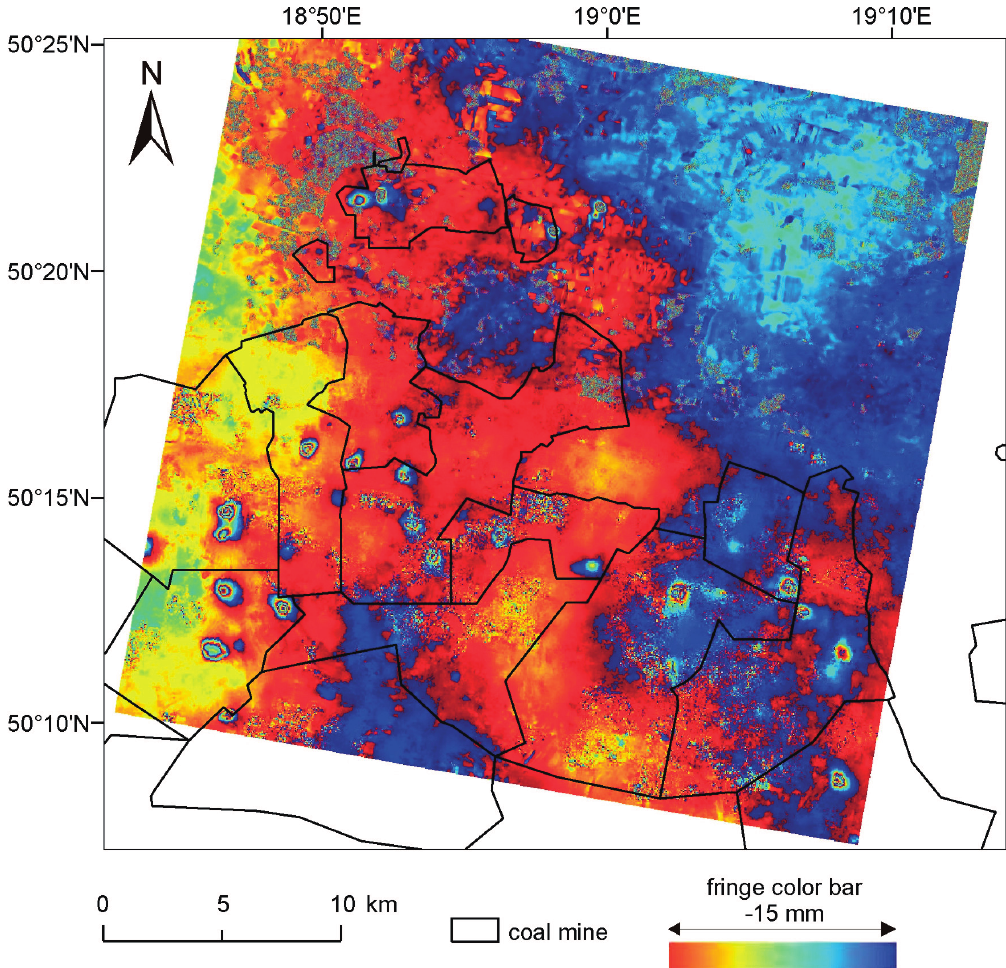
Figure 3. TerraSAR-X (TSX) X-band differential interferogram with boundaries of coal mining areas in Upper Silesia Coal Basin. Start and end dates of the interferogram are 25 November 2011–06 December